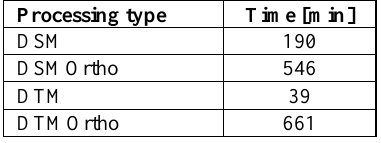
Figure 7 DTMOrtho showing a main junction without any distortions (data courtesy of Ordnance Survey,